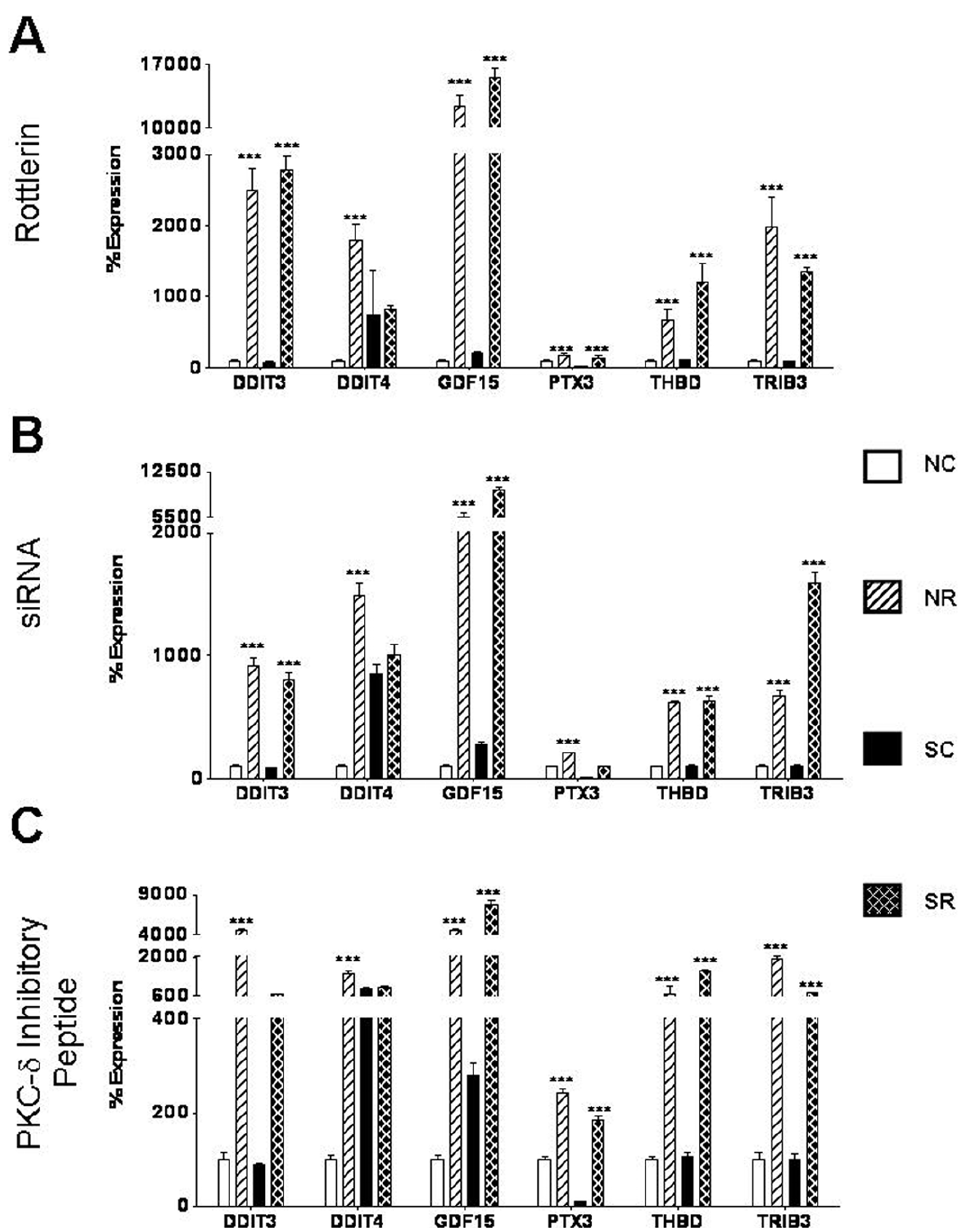
Figure 5. Validation of expression levels of upregulated genes following PKC- d inhibition. A. mRNA expression levels of 6 upregulated genes in normal and SSc human dermal fibroblasts following treatment with A. 5 m M rottlerin, B. 10 nM PKC- d siRNA, C. 10 m M cell permeable specific PKC- d inhibitory peptide for 24 h. Results are expressed as mean percent difference + / 2 SD of 3 replicate samples analyzed by quantitative RT-PCR. The PBS control was arbitrarily set to 100% expression. NC: Normal untreated fibroblasts, NR: Normal treated fibroblasts, SC: SSc untreated fibroblasts, SR: SSc treated fibroblasts. Statistical significance was calculated to compare treated vs untreated normal or SSc fibroblasts. *: p , 0.1; **: p , 0.01; ***: p , 0.0001.